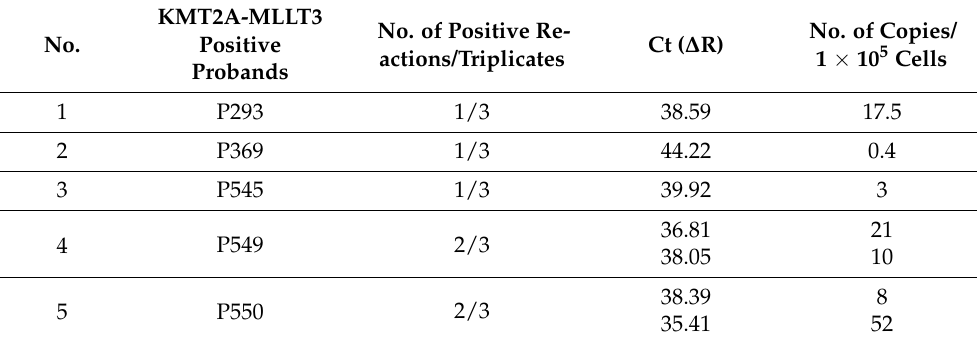
Table 3. RT-qPCR characteristics of KMT2A-MLLT3 positive samples validated further by standard PCR and